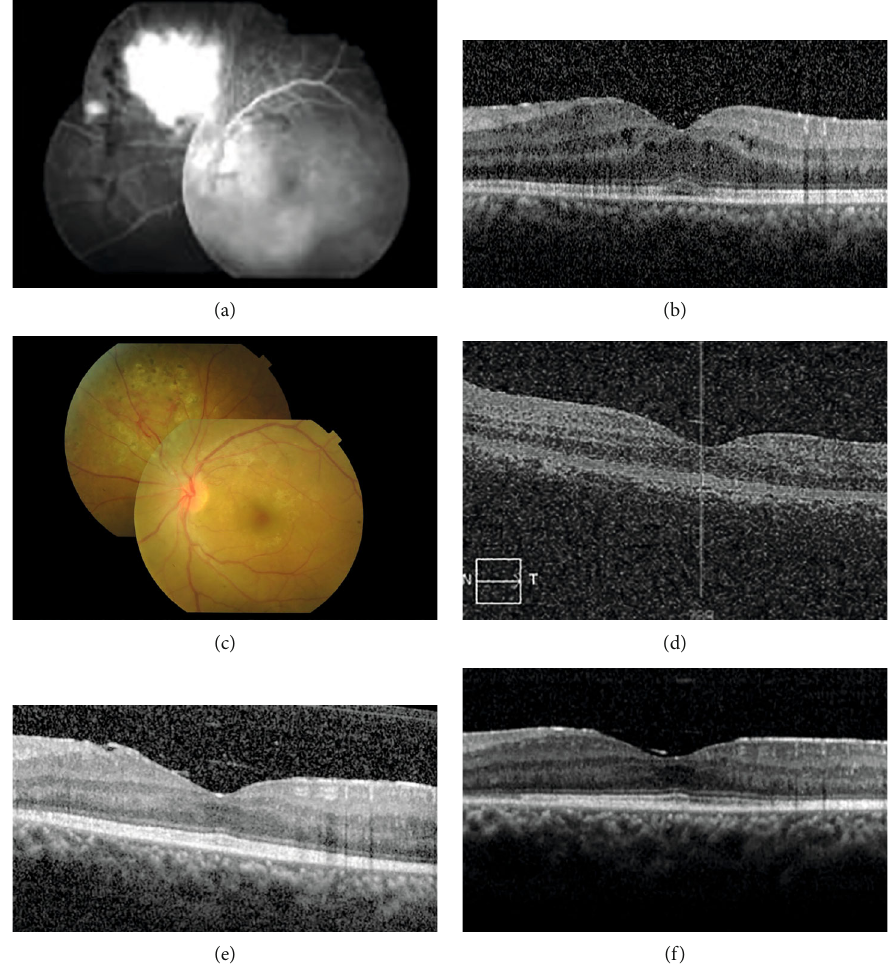
Figure 1: (a) FA showed vascular tortuosity, peripheral retinal neovascularization (NV), and macular edema (ME). (b) OCT revealed ME (central foveal thickness 376 μ m). (c) After the fi rst intravitreal a fl ibercept injection, the retinal NV regressed. (d) ME also decreased (central foveal thickness 293 μ m). (e) ME recurred 5 months after the fi rst intravitreal a fl ibercept injection (central foveal thickness 305 μ m). (f) No recurrent ME 15 months after the third intravitreal a fl ibercept injection (central foveal thickness 295 μ